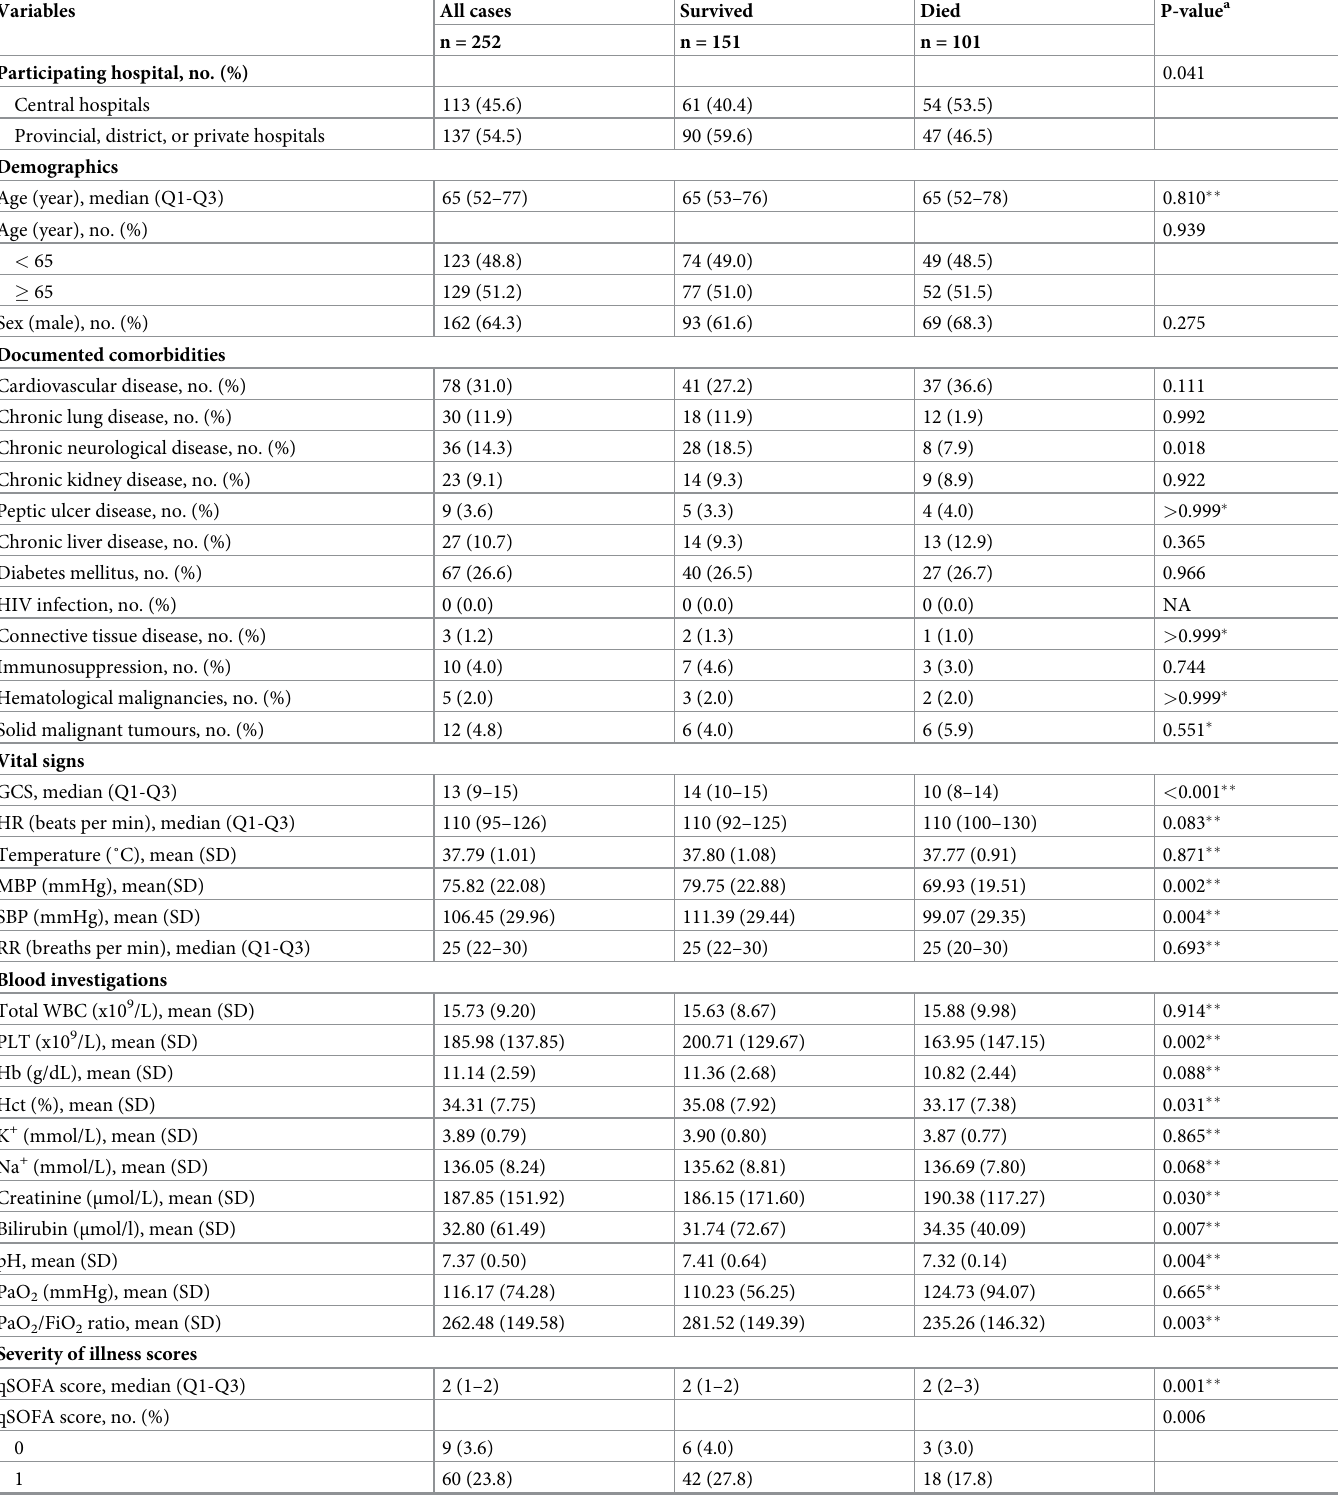
Table 1. Demographics and baseline characteristics of intensive care unit patients with sepsis according to hospital